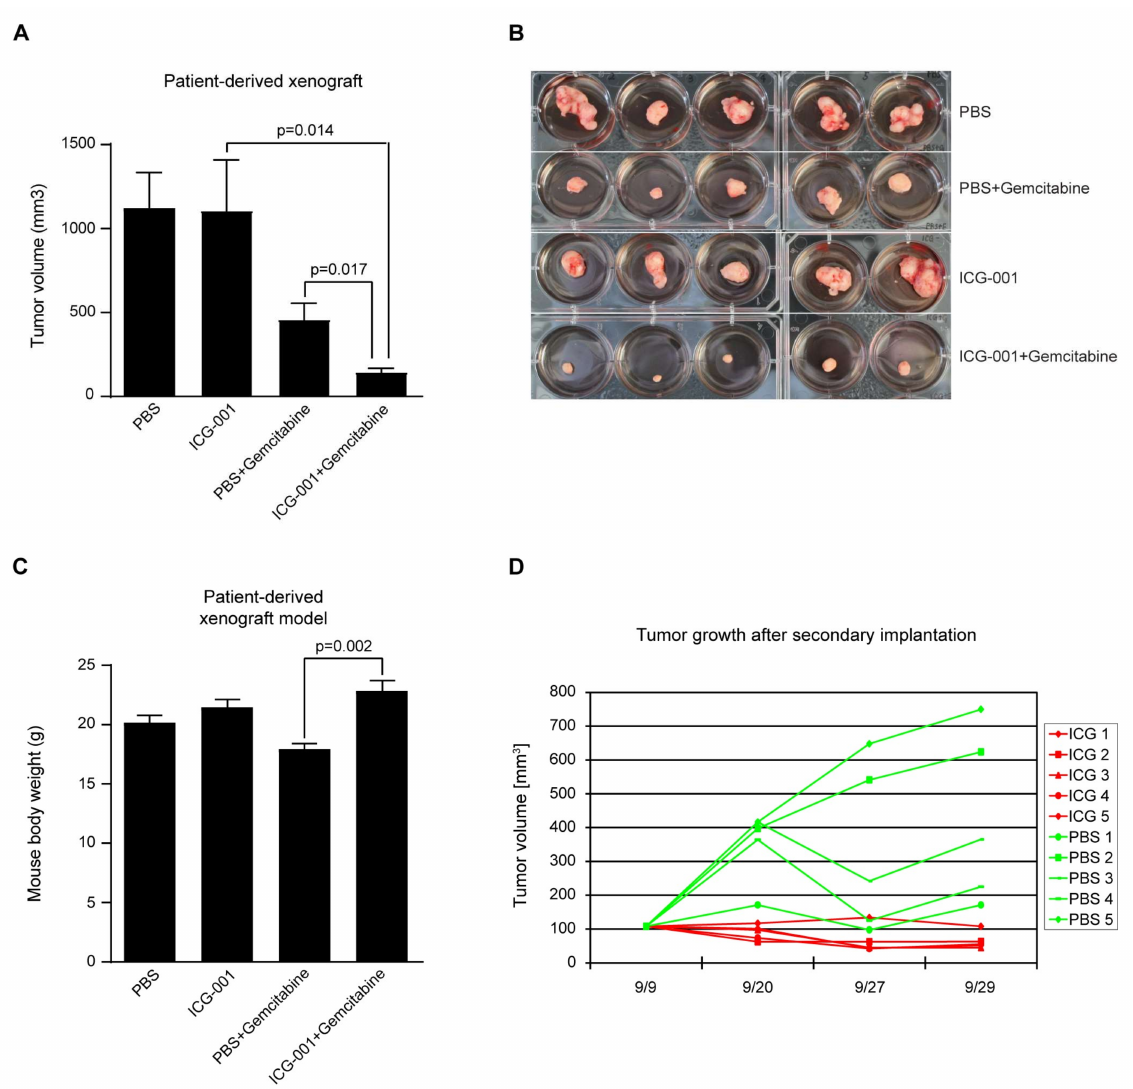
Figure 5. Combination ICG-001 and gemcitabine treatment suppresses human patient-derived PDAC in a mouse xenograft model; ICG-001 effectively targets tumor-initiating cells. ( A – C )